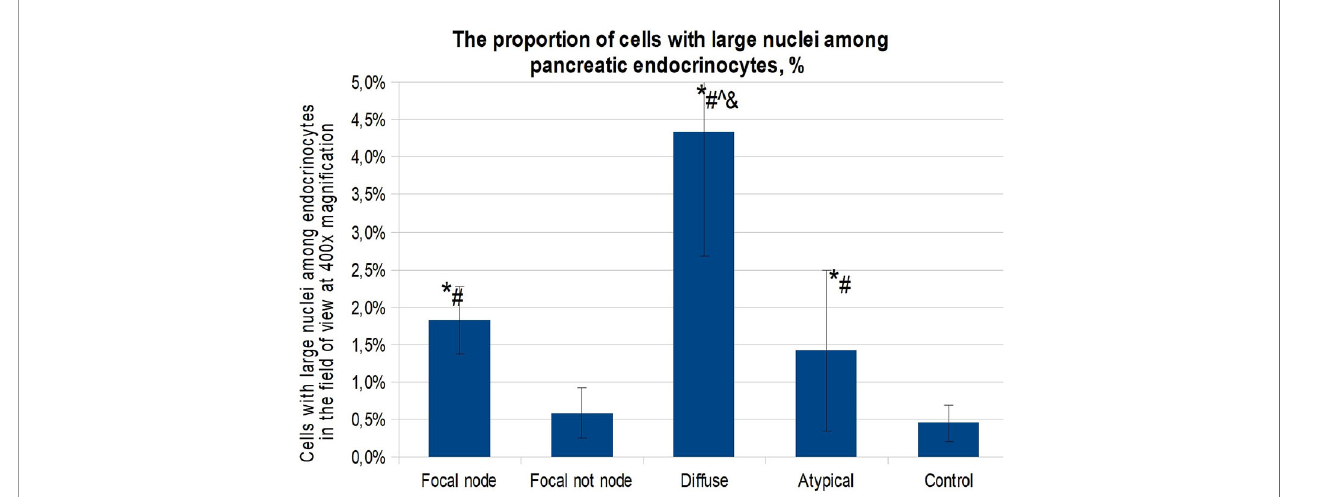
FIGURE 7 | The proportion of cells with enlarged nuclei among endocrinocytes in the fi eld of view (percentage), paraf fi n sections. Data are presented as M ± SD. (*) - the difference in comparison with the control is statistically signi fi cant at p <0.01; (#) - the difference in comparison with the area of unchanged tissue in the focal form is statistically signi fi cant at p <0.01; (^) - the difference in comparison with the zone of adenomatous hyperplasia is statistically signi fi cant at p <0.01; (&) - the difference compared to the atypical form is statistically signi fi cant at p <0.01. Note: focal node - zone of adenomatous hyperplasia in focal form; focal not node - pancreatic tissue outside the zone of adenomatous hyperplasia; diffuse - diffuse form; atypical - atypical